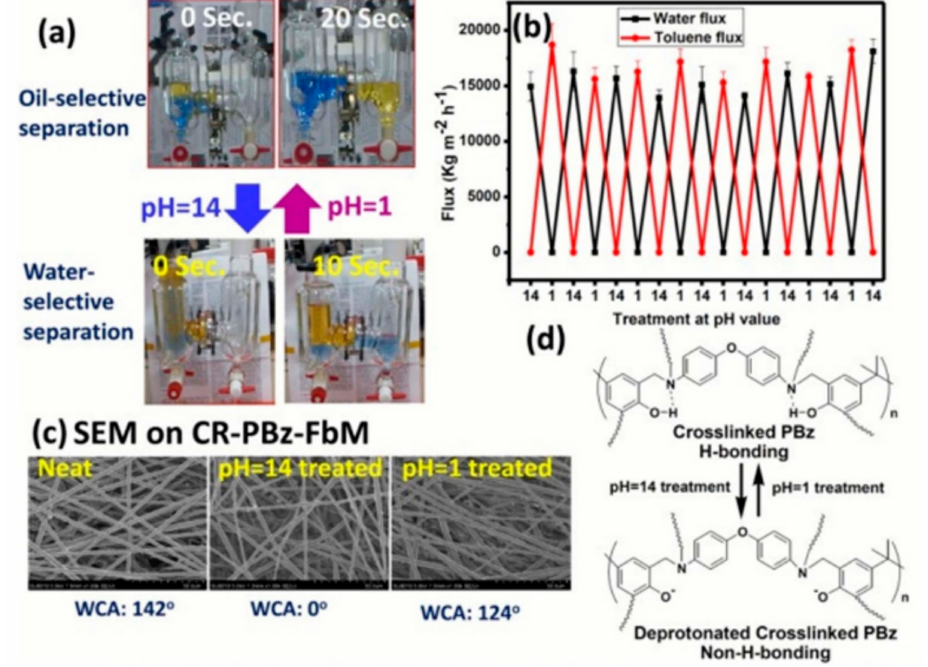
Figure 11. ( a ) pH-induced switchable membrane in oil / water separation; ( b ) flux data of the membrane at di ff erent pH values; ( c ) SEM images of the membrane at di ff erent pH values; ( d ) schematic illustration of the changes in the chemical structure of CR–PBz–FbM at di ff erent pH values. Reproduced with permission from [209]. Copyright 2016 The Royal Society of